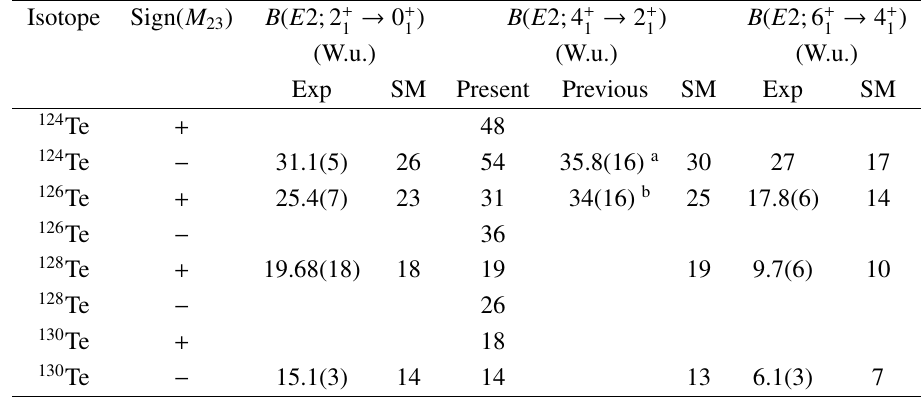
Table 6. Transition strengths in 124 − 130 Te. Data from Nuclear Data Sheets [26–29] and the present work. Transition strengths measured in this work are given without uncertainties. A 20% uncertainty is assumed for all measured transition strengths. Experimental values are given next to the signs of the matrix elements predicted by the shell-calculations (SM). Details of the shell-model calculations are given in the text.